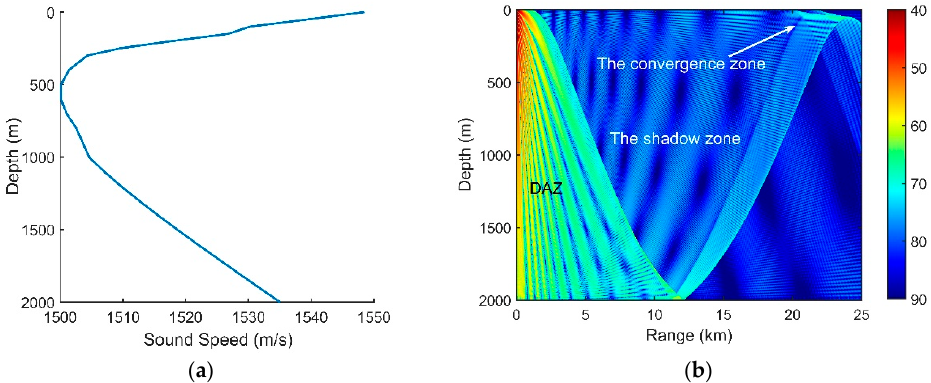
Figure 20. ( a ) Measured sound speed profile; ( b ) Transmission loss for a source at a 50-m depth at the frequency of 350 Hz.